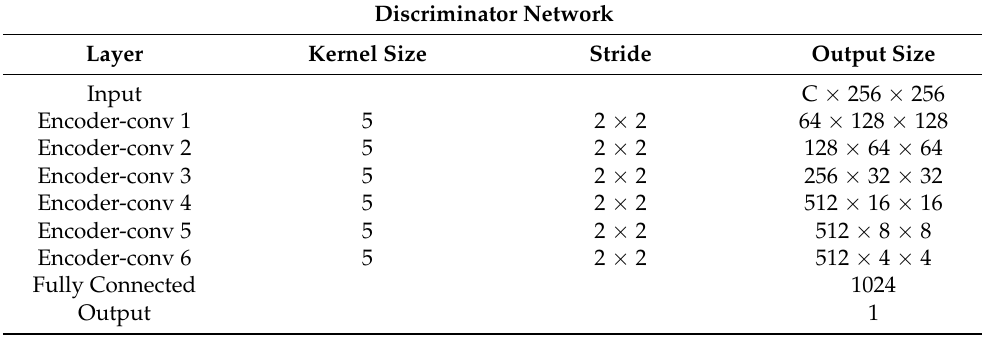
Table 2. Discriminator architecture